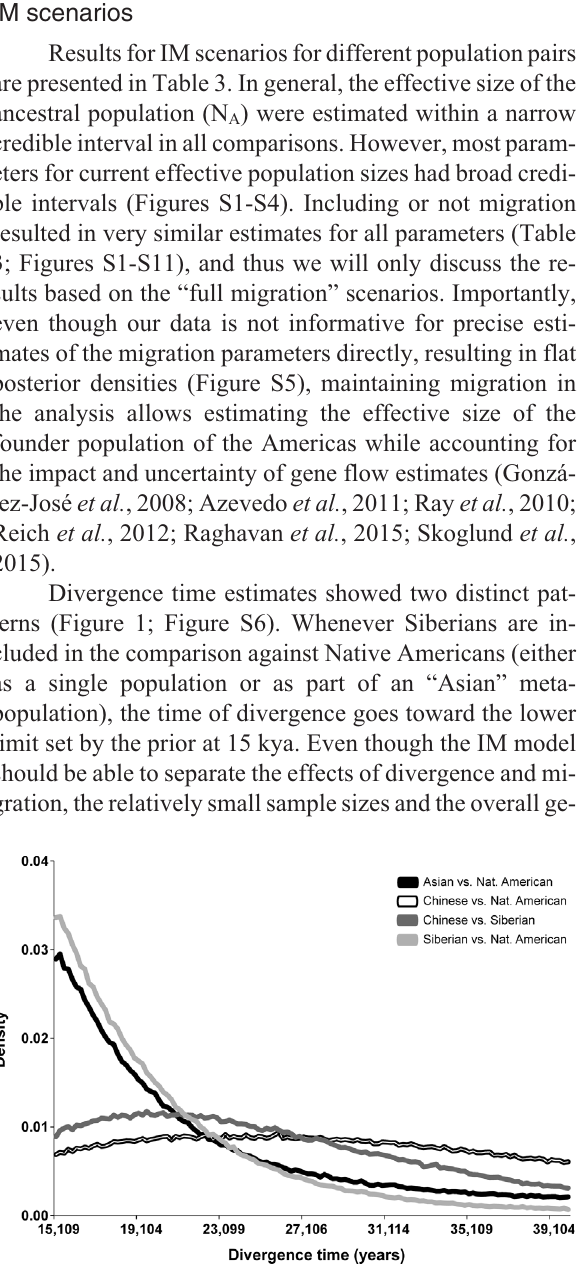
Figure 1 - Posterior densities for divergence time (years) in all scenarios tested including migration. Divergence between Asian and Native Ameri- can is shown in solid black, between Chinese and Native American in white with black contour, between Chinese and Siberian in dark gray, and betweenSiberianvs.NativeAmericaninlightgray,asshowninthegraph- ical